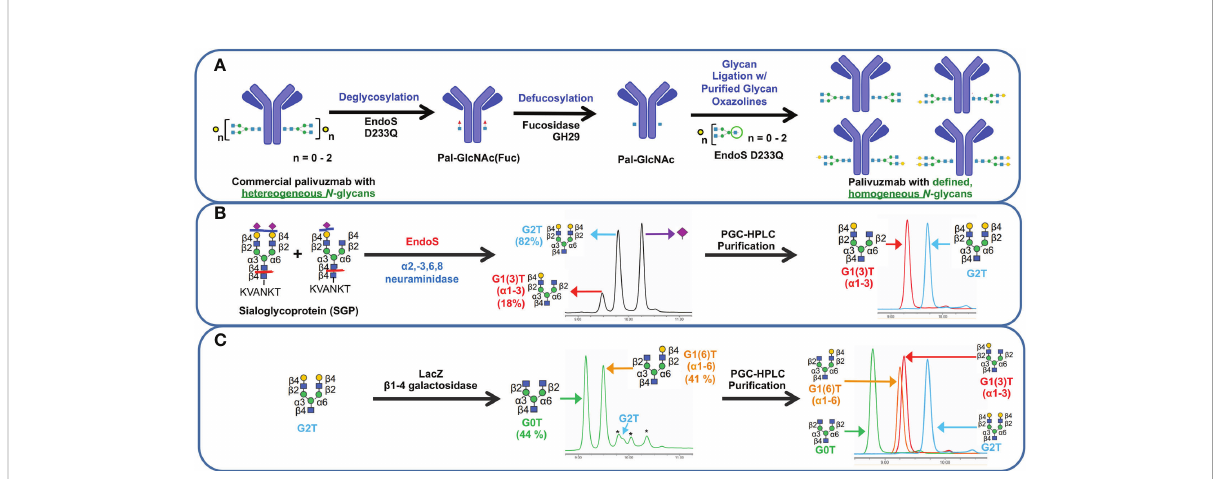
FIGURE 1 Schematic representation of transglycosylation of palivizumab to generate homogeneous glycoforms. (A) Deglycosylation of commercially- available palivizumab using EndoS D233Q generates the truncated GlcNAcFuc disaccharide (blue square = GlcNAc; red triangle = fucose) remaining on palivizumab. Defucosylation is achieved using fucosidase GH29, and subsequent glycan ligation of puri fi ed glycan oxazoline is achieved using EndoS 233Q. (B) Enzymatic reaction and puri fi cation of truncated glycans (mono-galactosylated at the a 3 antenna (G1 (3)T) and digalactosylated (G2T)) using EndoS and a 2-3,6,8 neuraminidase to cleave truncated glycans between the reducing end chitobiose core, followed by puri fi cation by porous graphitic carbon (PGC)-HPLC. (C) Synthesis of truncated agalactosylated (G0T) and monogalactosylated at the a 6 antenna (G1 (6)T) glycans using LacZ b 1-4 galactosidase (* indicates reaction byproduct peaks), followed by puri fi cation by PGC-HPLC. HPAEC-PAD trace of overlaid spectra of puri fi ed glycans are shown on the right in each of (B, C)